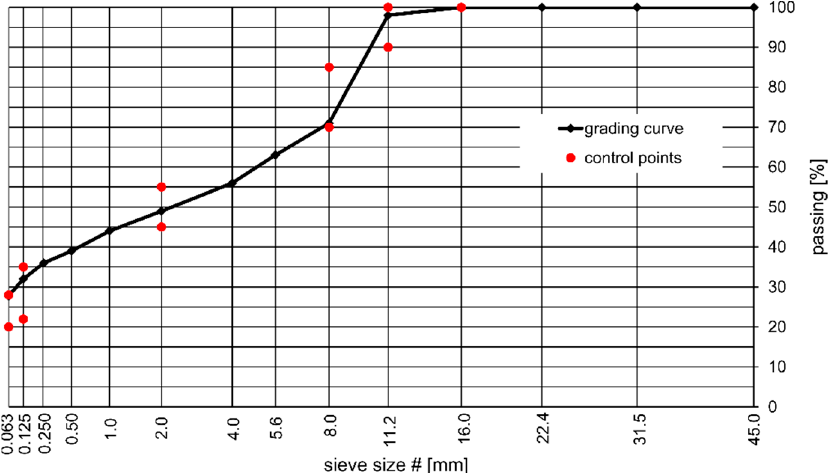
Figure 1. Grading curve of the tested MA 11 mixture.